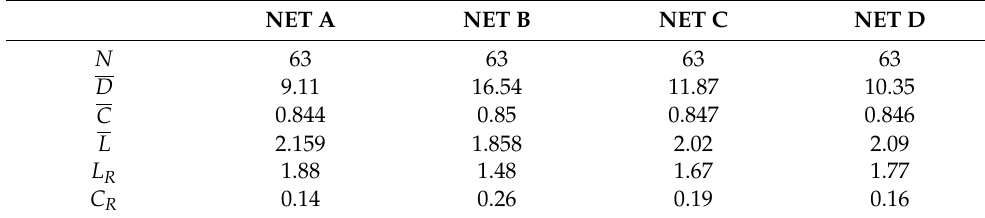
Table 2. L R and C R metrics of four network models.